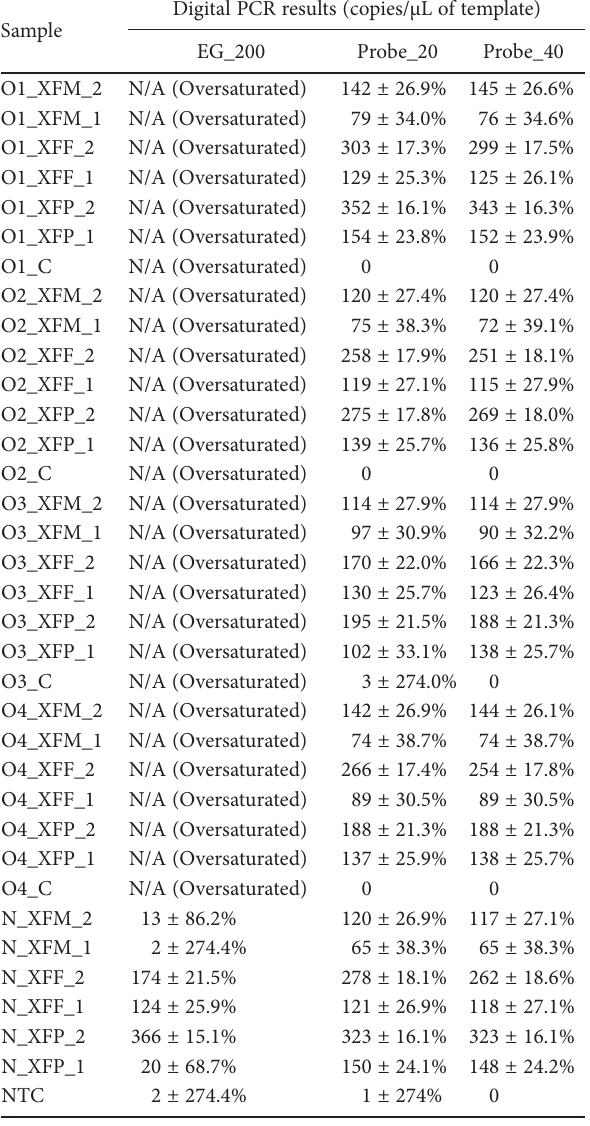
Table 4. Results of dPCR assays on the second set of samples, posi- tive and negative controls. The table reports the target copy num- ber/µL for each sample, the error is calculated as a CI of 95%. The columns report the results obtained with either the Probe method with the two considered thresholds, or with EG with threshold at 200. Copy number was rounded to the closest unit. The error is rounded to the closest